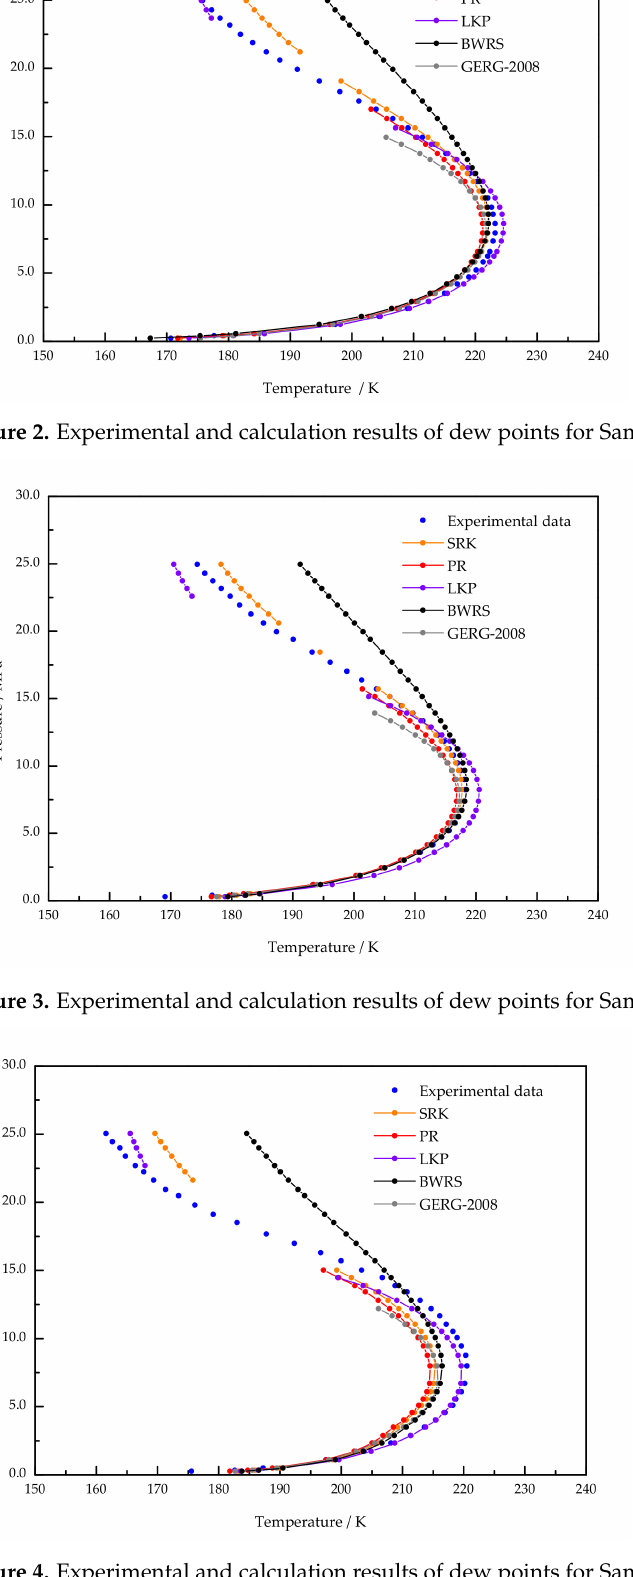
Figure 4. Experimental and calculation results of dew points for Sample